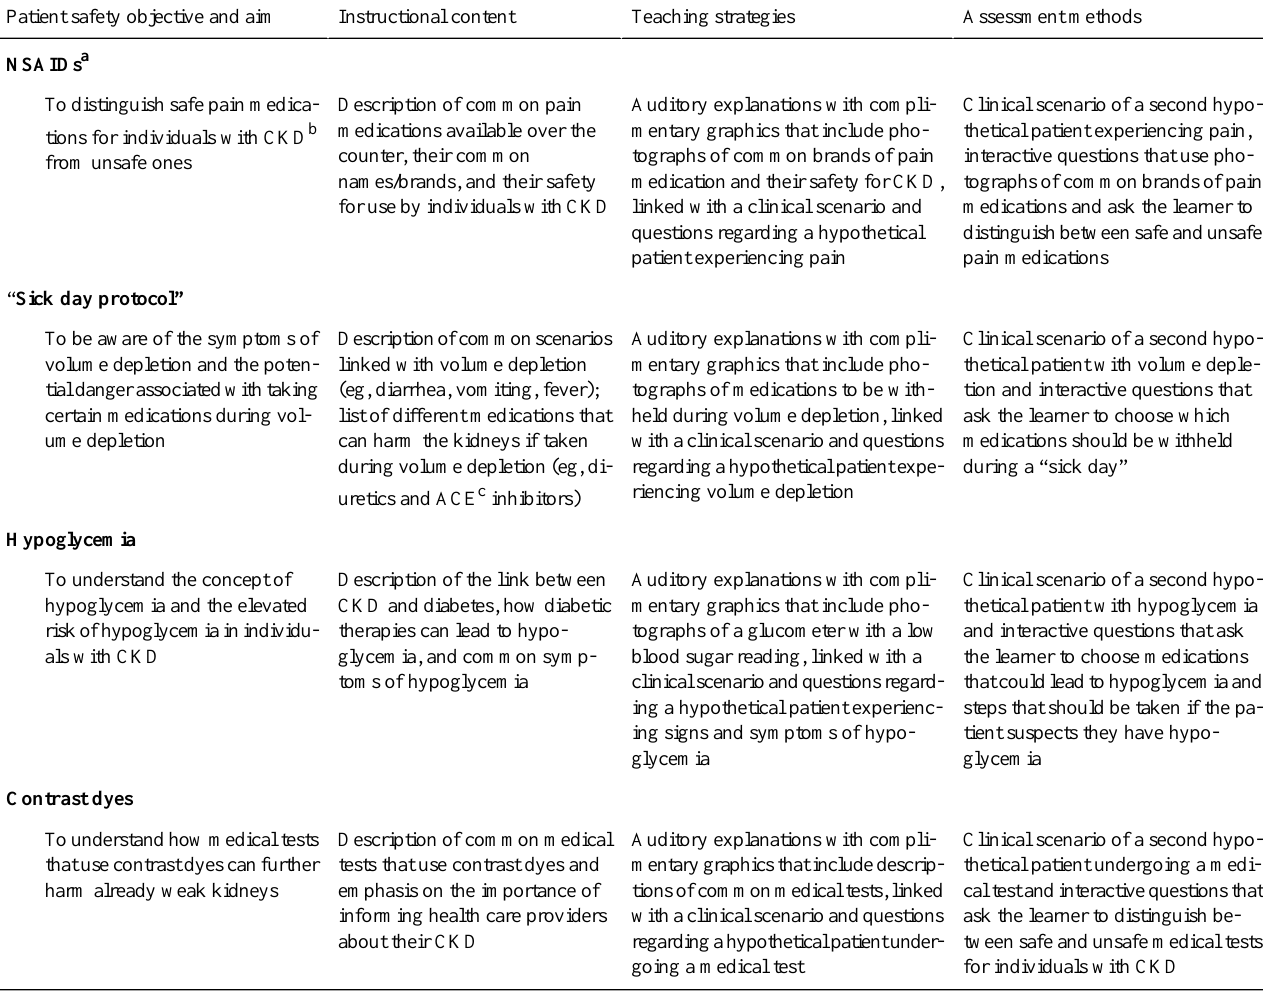
Table 1. Patient safety objectives, aims, instructional content, teaching strategies, and assessment methods of the developed tool.